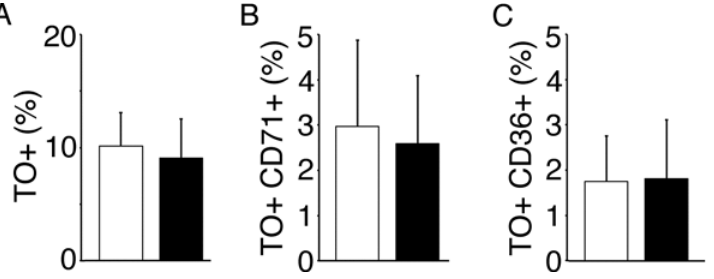
Fig 2. Reticulocyte phenotyping in CTT and non-transfused control groups. Mean TO%, mean CD71+, and mean CD36+ (A,B,C) of non-transfused control group (open bars) and transfused group (black bars). Standard deviation bars are